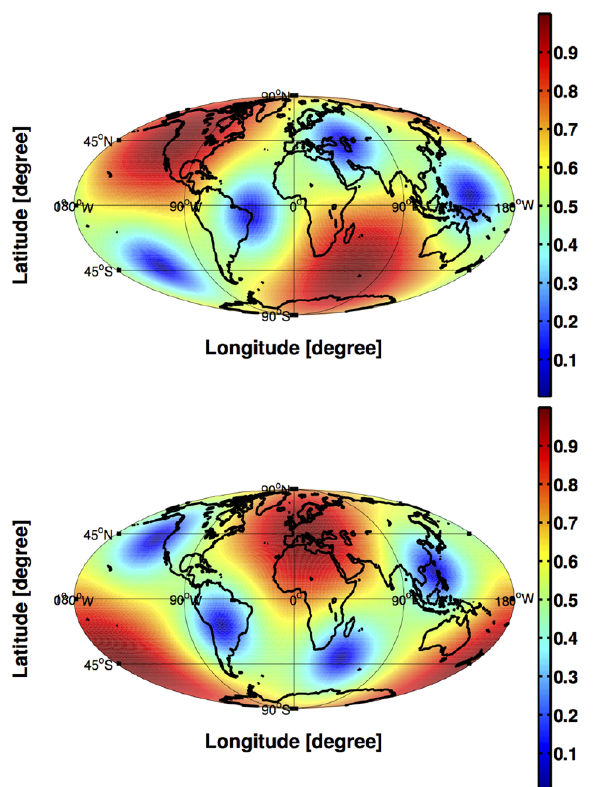
Fig. 31 Antenna patterns for the strain response to unpolarized gravitational waves for the LIGO Hanford ( top panel ) and Virgo ( bottom panel ) interferometers evaluated in the small-antenna limit. The antenna patterns are represented as colorbar plots on a Mollweide projection of the Earth. Note that the maxima of the antenna patterns (the centers of the red regions ) are directly above (and below ) the location of the two interferometers—in Hanford, WA and Cascina, Italy, respectively. The blue regions correspond to the minima of the antenna patterns—i.e., the ‘dimples’ in the left panel plot of Fig.